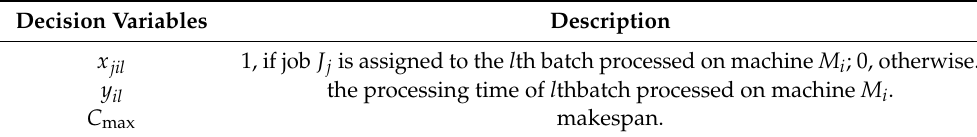
Table 3. Decision